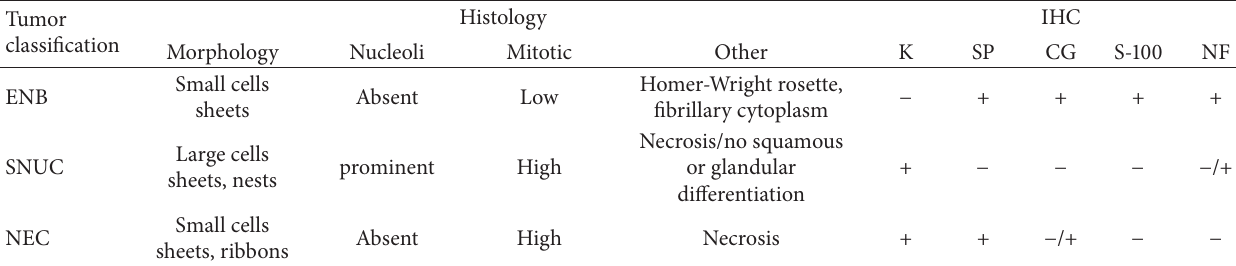
ENB: esthesioneuroblastoma, SNUC: sinonasal undifferentiated carcinoma, NEC: neuroendocrine carcinoma, K: keratin, SP: synaptophysin, CG: chromo- granin, NF: